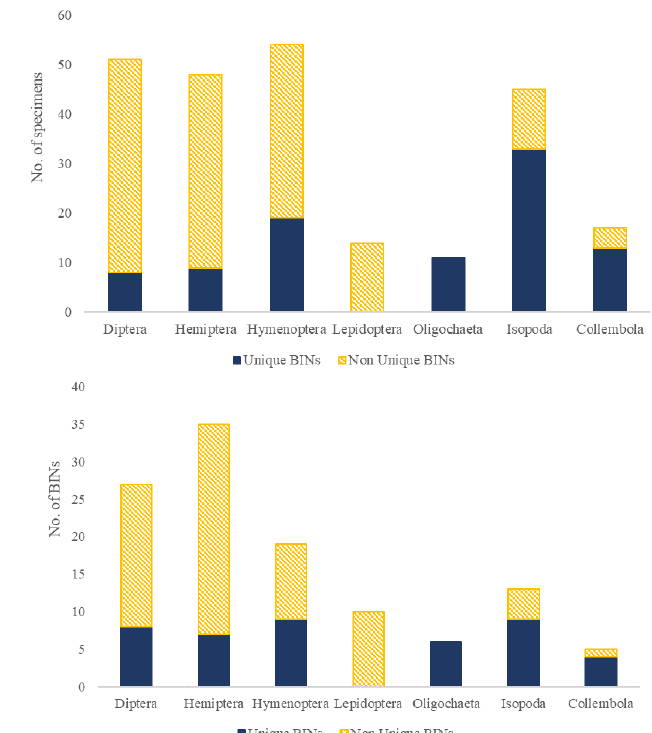
Figure 2. Observed BINs, shown as a ratio between Non-Unique BINs (yellow pattern) and Unique BINs (blue) within different groups: Diptera, Hemiptera, Lepidoptera, Hymenoptera, Isopoda, Collembola, and Oligochaeta, represented as a number of specimens belonging to each BIN type ( a ) or as a number of each BIN type ( b ).